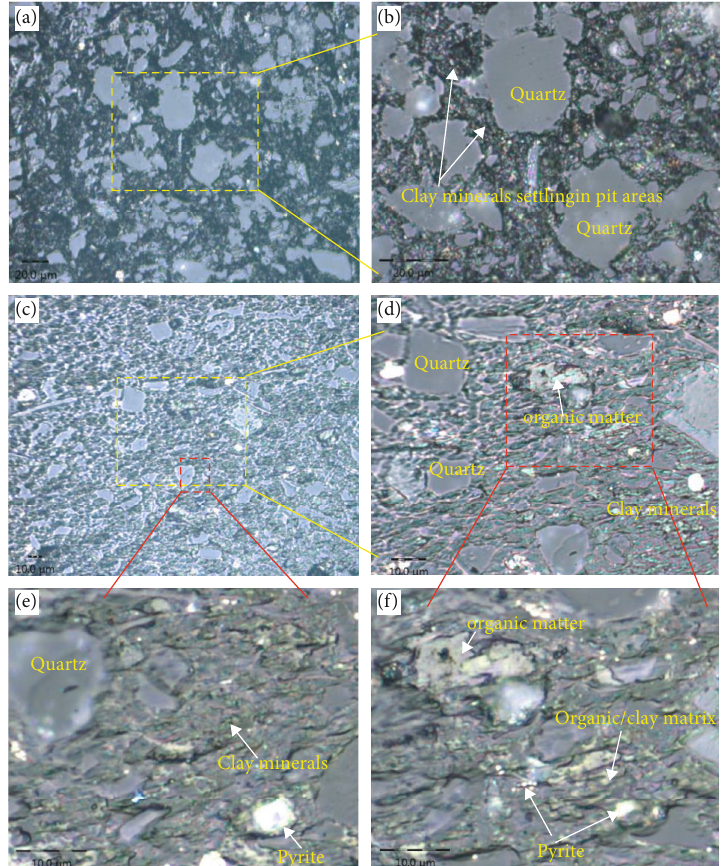
Figure 2: Photomicrographs of quartz and clay minerals. The surface morphology of quartz and clay minerals is shown after (a – b) mechanical polishing and (c – f) ion polishing. Quartz is dark gray, translucent, contains small impurities, and has straight and sharp edges without a regular shape. The clay minerals are opaque and black after mechanical polishing, and located in pit areas as lumps or isolated grains along with organic matter. Magni fi cations: (a) and (c) 20 × objective lens; (b) and (d) 50 × objective lens; (e – f) 100 × objective lens (the eyepiece magni fi cation was 40 × for all